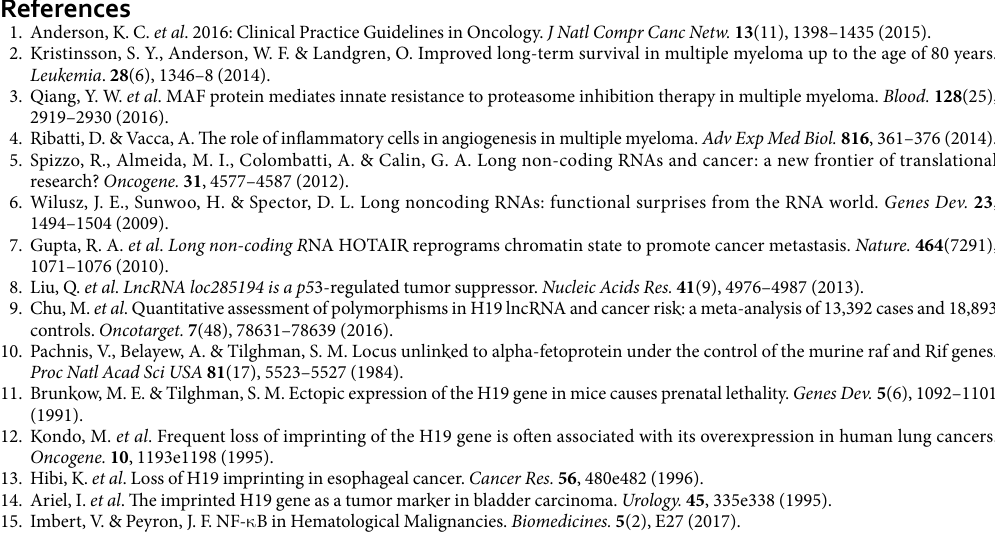
9 Scientific REPORts | (2017) 7:18079 | DOI:10.1038/s41598-017-18056-9